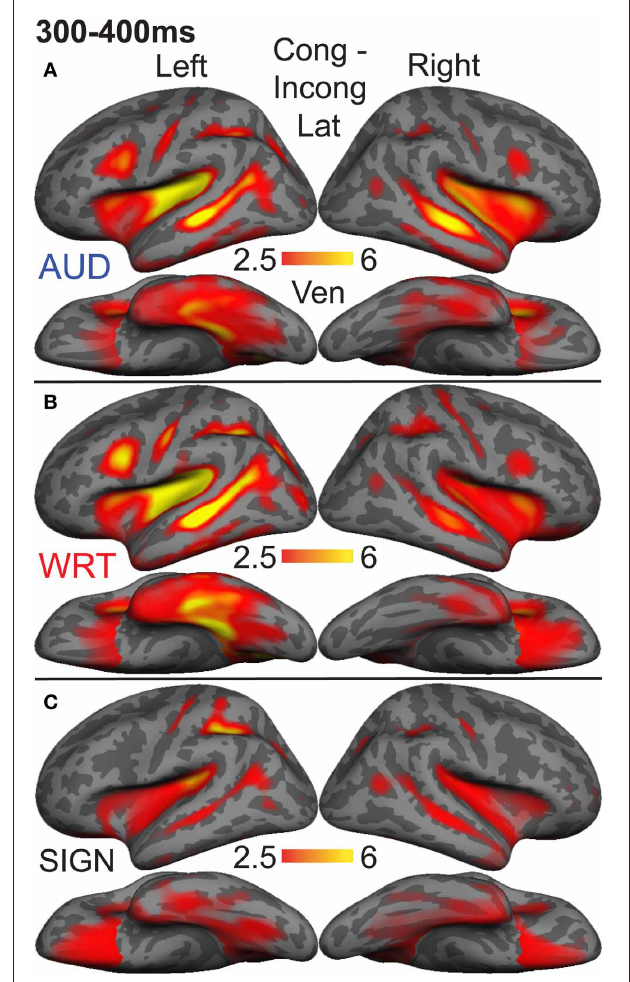
FIGURE 5 | Grand average group dSPMs during the early encoding time window from 150 to 200ms. (A) Auditory words (“AUD”) continue to evoke activity in bilateral superior temporal cortex, while (B) Written words (“WRT”) show a modality-specific peak in left vOT. (C) Signed words (“SIGN”) show a modality-specific peak in right IPS. F -values on the color bars represent signal-to-noise ratios.